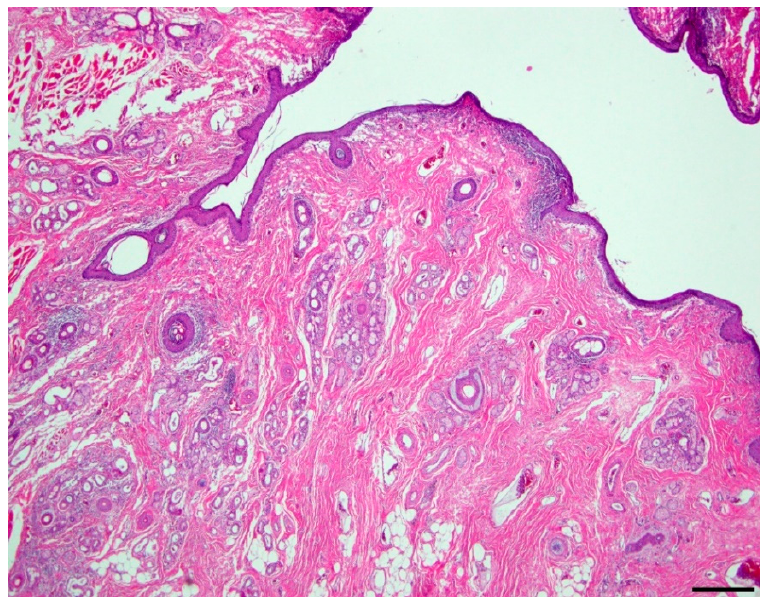
Figure 2. Duplicated urethra, lumen (200x; hematoxylin and eosin). Multifocally, the urothelium lining the central lumen transitions to a non-keratinizing, stratified squamous epithelium. The supporting fibrovascular stroma contains low numbers of hair follicles with associated adnexa; bar = 100 µm.